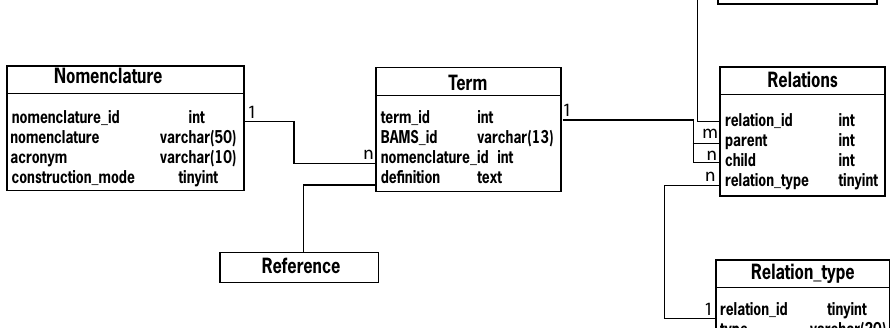
Figure 1. The OR schema of BAMS Neuroanatomical Ontology .